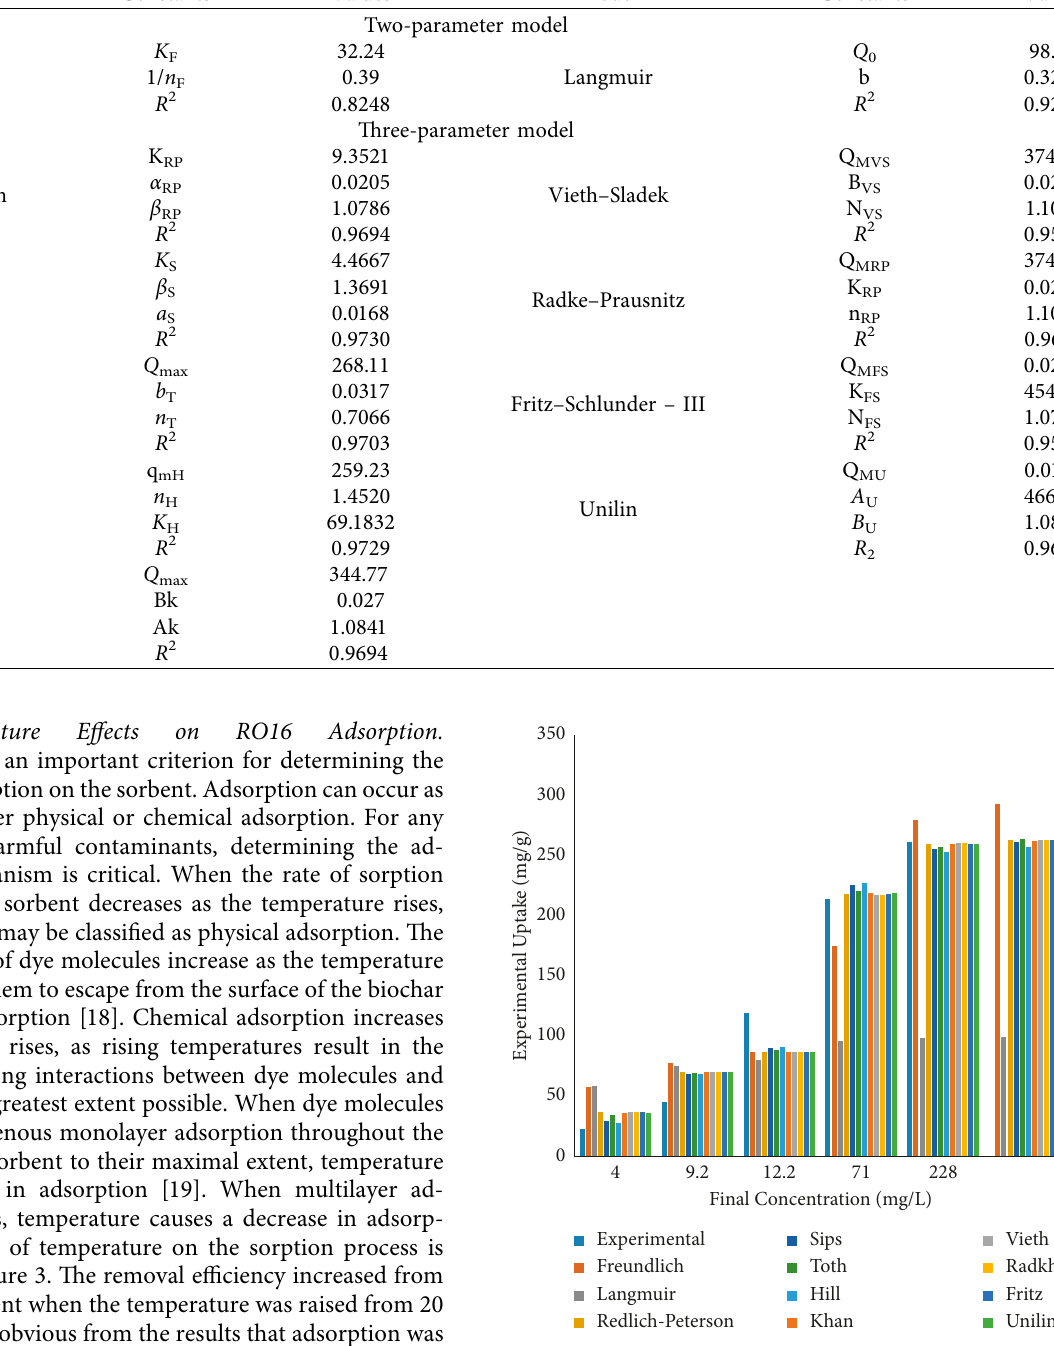
Figure 4: Dye sorption isotherms on RO16 removal using Ulva prolifera- derived